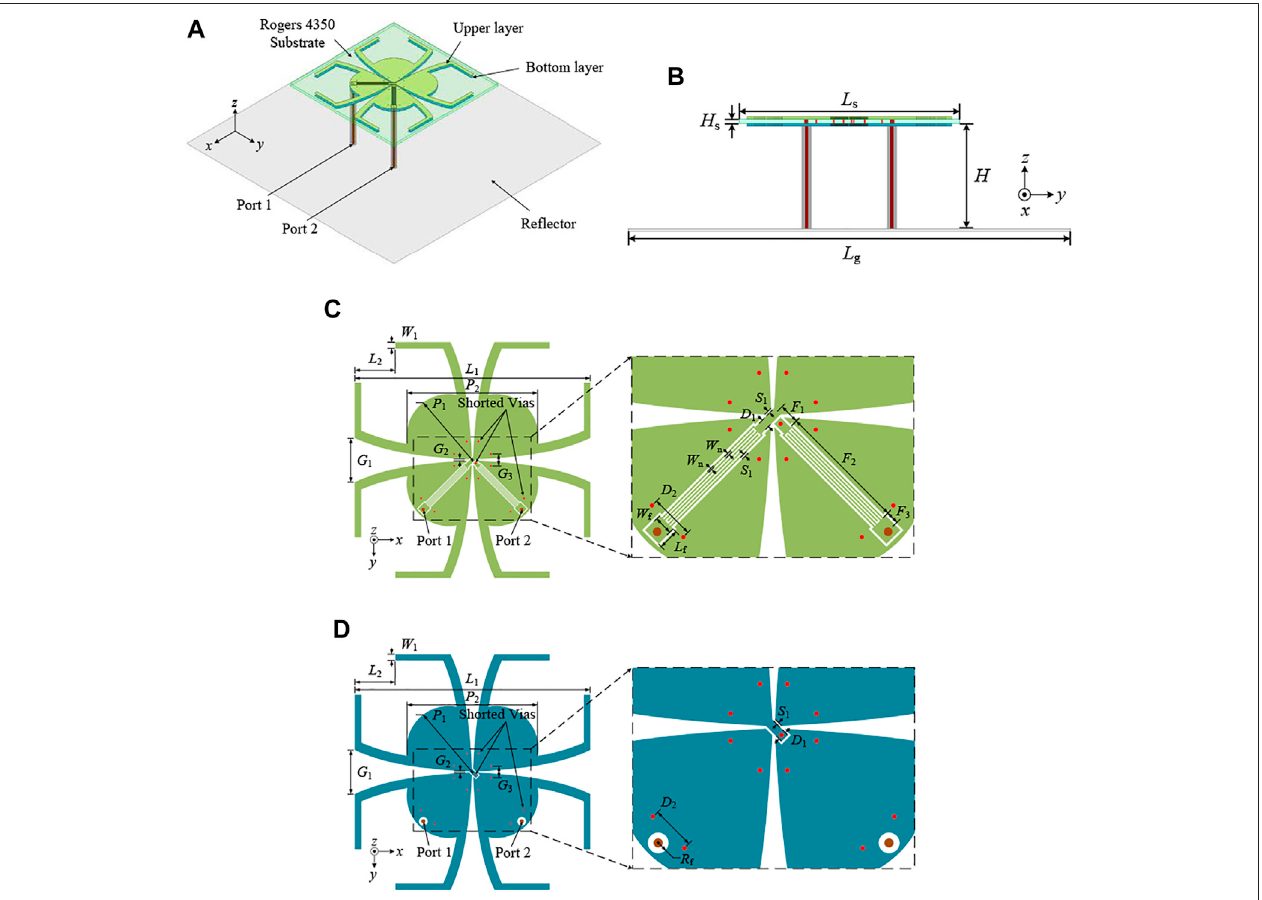
FIGURE1|(A) Overallstructure. (B) Sideview.( L g (cid:1) 80, L s (cid:1) 40, H (cid:1) 19, H s (cid:1) 0.787 mm). (C) Upper layerfromtopview. (D) Bottomlayerfromtopview.( D 1 (cid:1) 0.6,